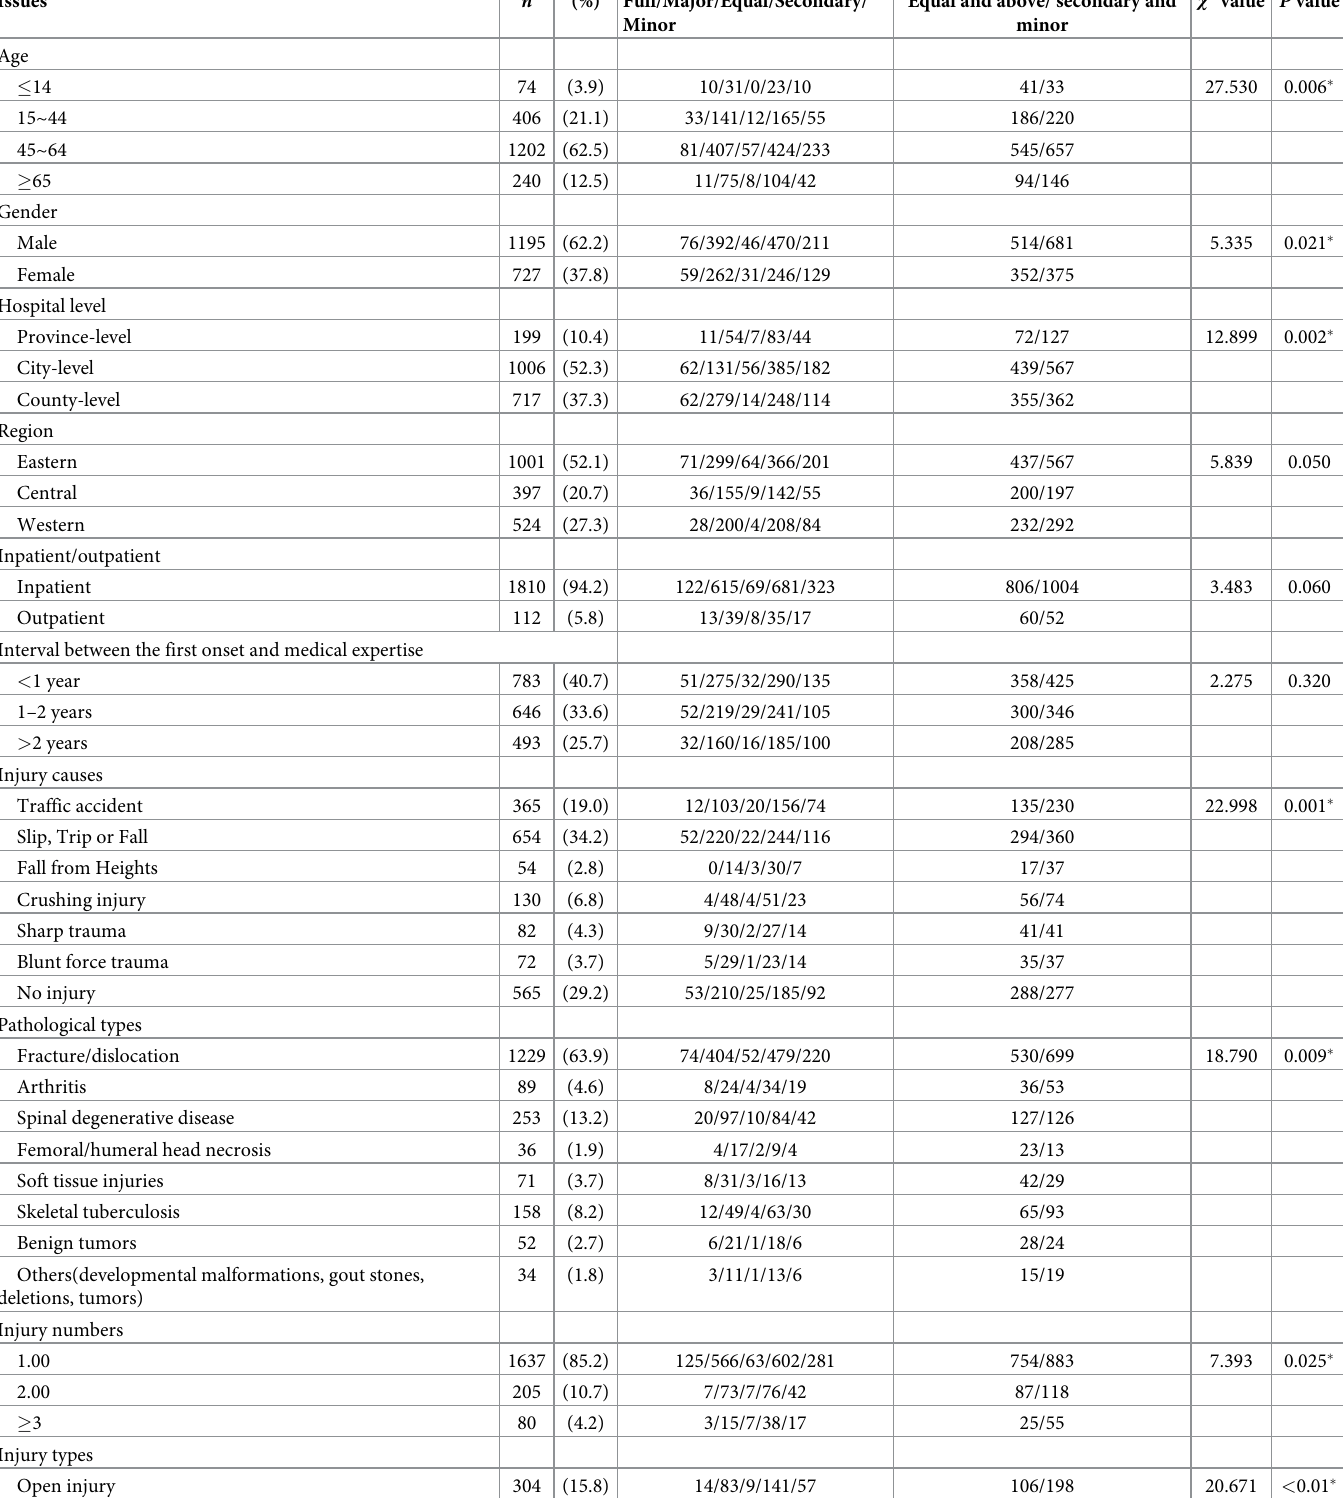
Table 1. Case characteristics of orthopedist’s degree of responsibility for medical malpractice in China between 2016 and